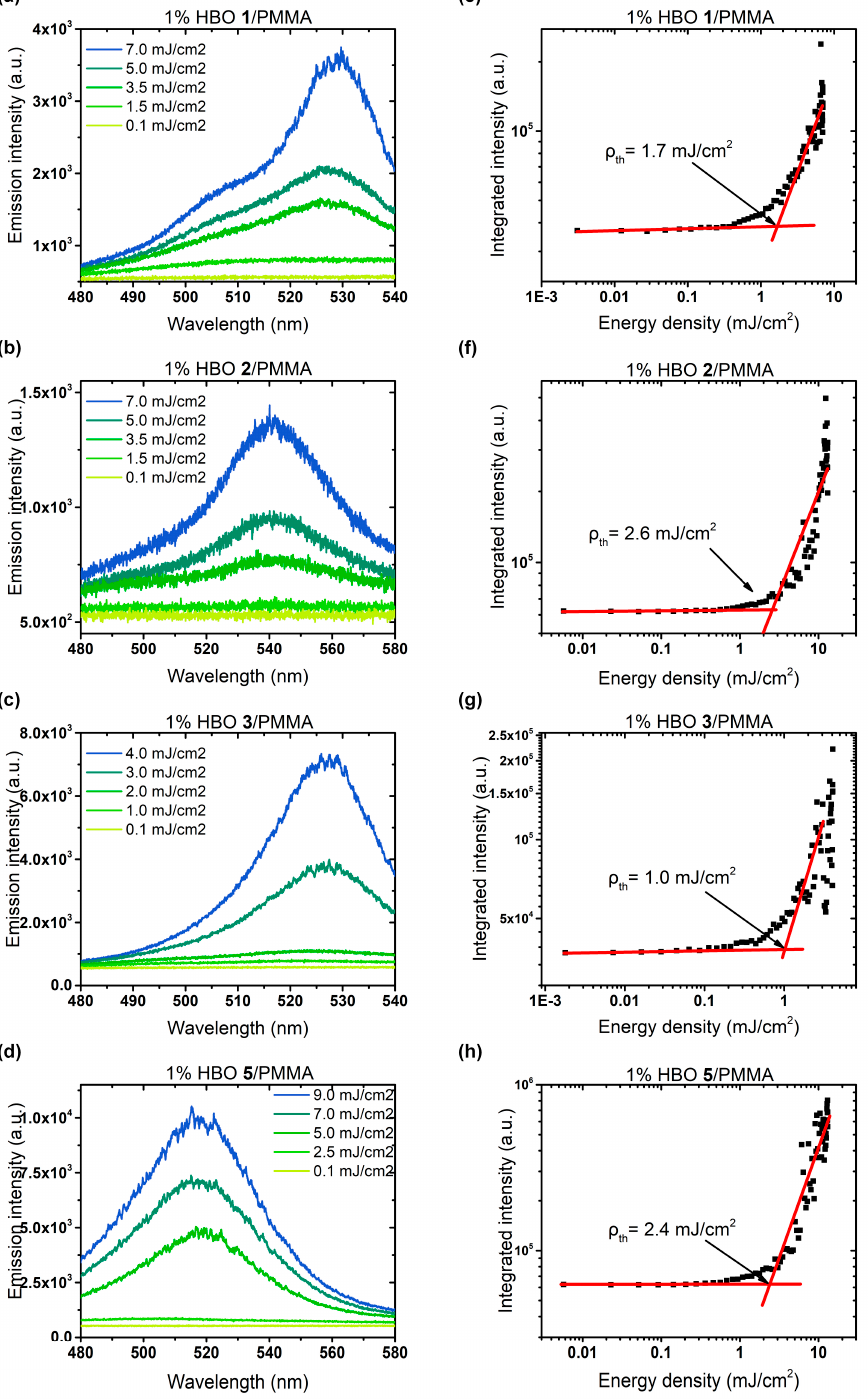
Figure 8. ( a – d ) Dependence of the light emission spectra on the excitation energy density for 1% doping of ESIPT dyes 1 – 3 and 5 in the PMMA sample and ( e – h ) corresponding integrated emission intensity as a function of the pumping energy density for the same samples, along with the calculated threshold.